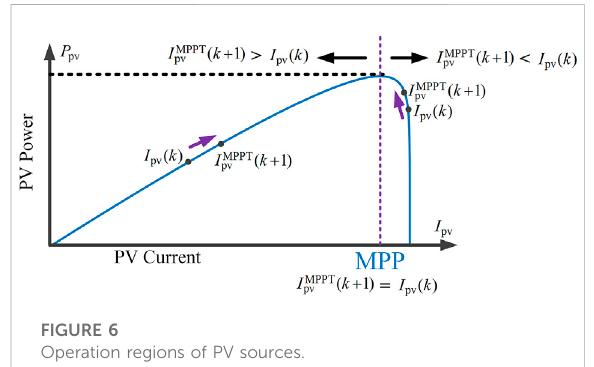
FIGURE 6 Operation regions of PV sources.